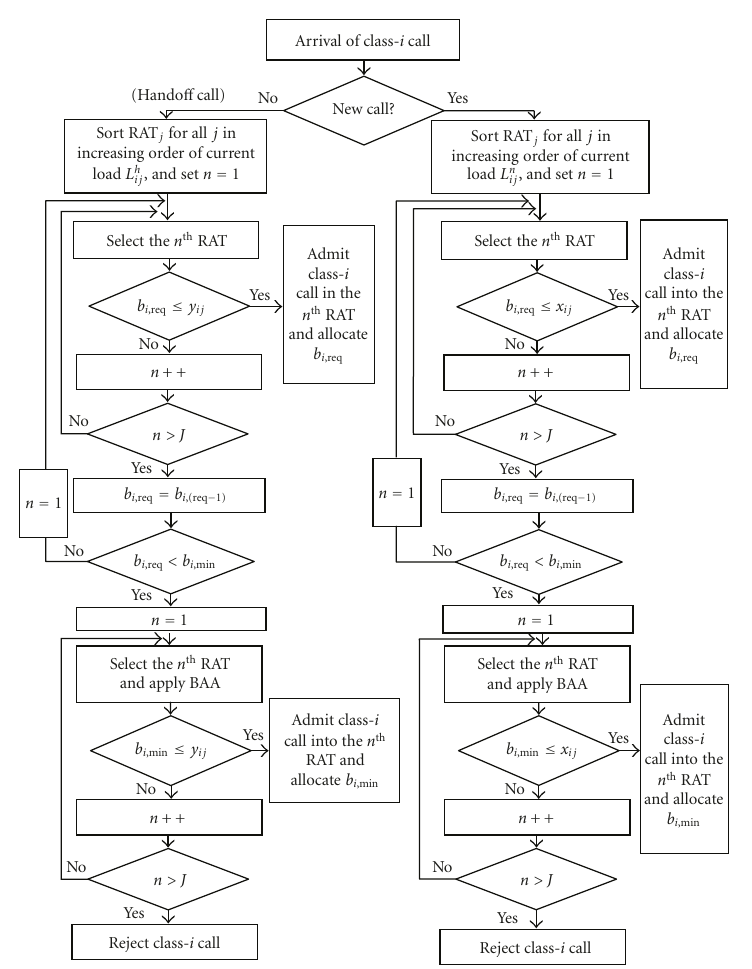
Figure 2: Proposed adaptive load-based JCAC algorithm.